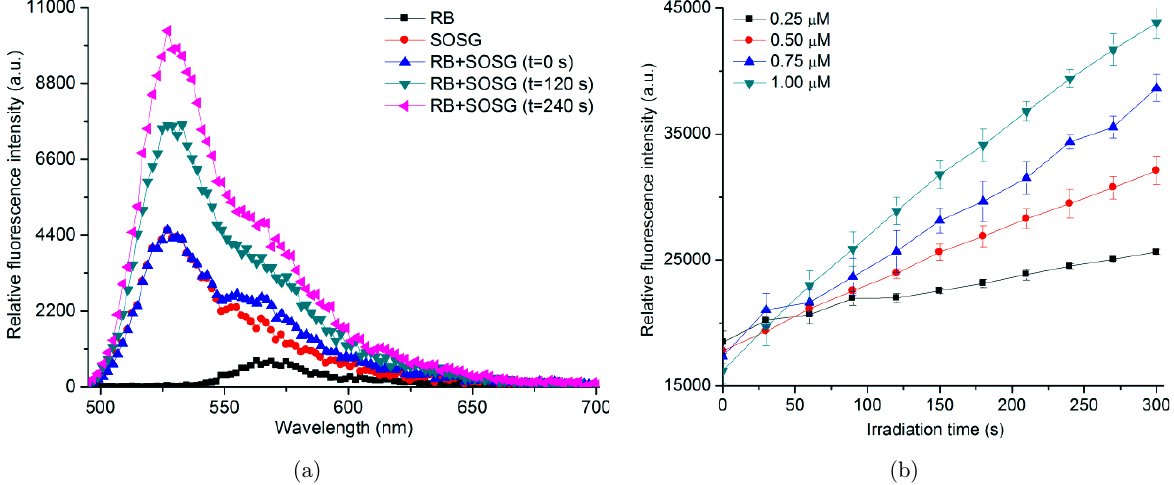
Fig. 2. (a) Fluorescence emission spectra of 1.00 (cid:1) M RB and 1.00 (cid:1) M SOSG before irradiation and a mixture of RB þ SOSG before and at two di®erent time points after irradiation. (b) Reaction of 6.00 (cid:1) M SOSG with 1 O 2 generation from various concentrations of RB. Fluorescence excited at 488